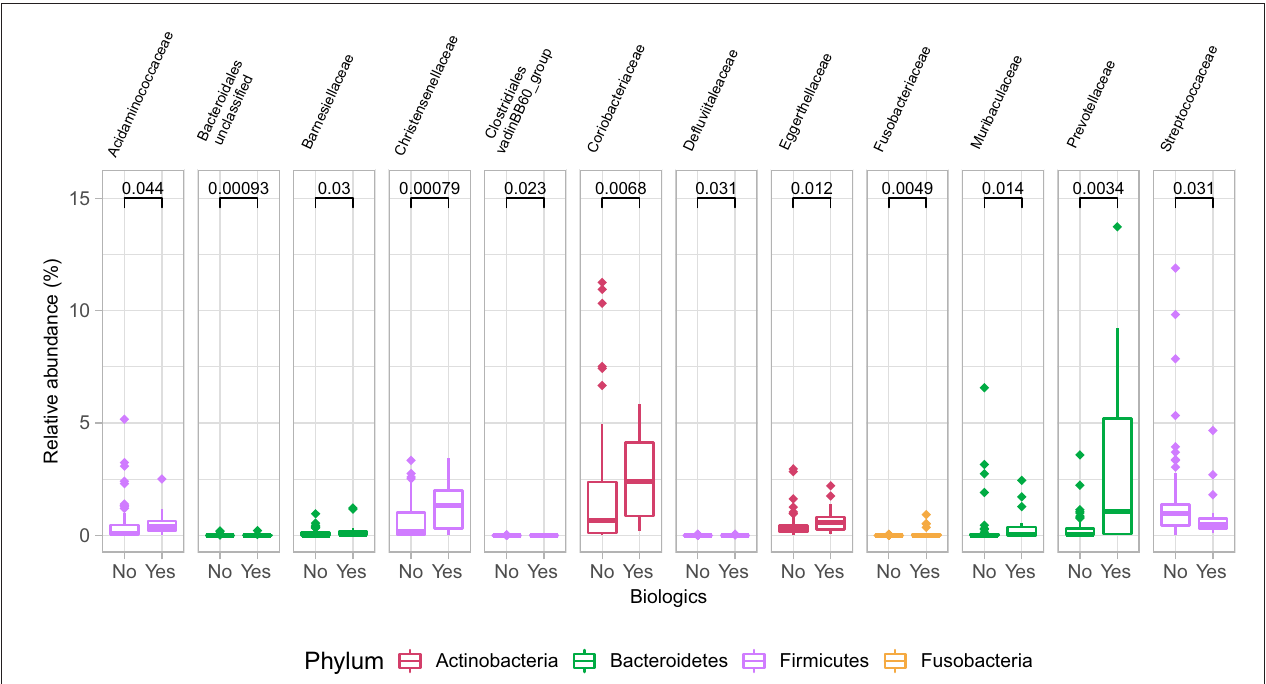
FIGURE 9 | Differences in some microbial family abundances between the two treatment options in UC group. Only significant results are shown (Wilcoxon, p ≤ 0.05).